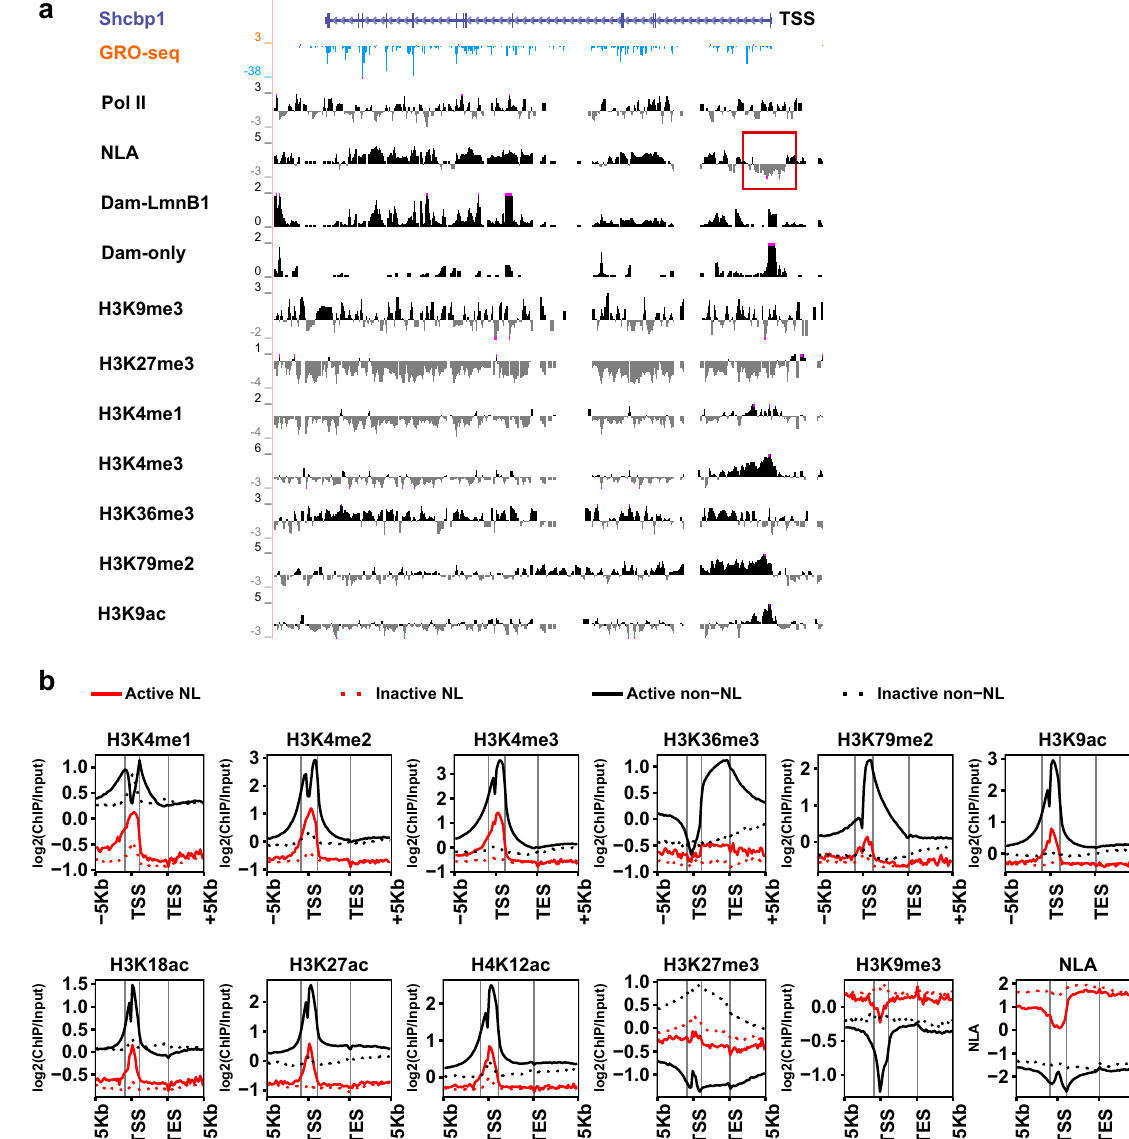
Figure 3. Combined analyses of gene activity, NLA and histone marks across genic regions. ( a ) The UCSC browser view of Shcbp1 – an active NL gene in C2C12 myoblasts. Data are binned in 200 bp. Tracks “Dam- LmnB1” and “Dam-only” display read densities (RPKM) of Dam-LmnB1 and Dam-only, respectively. Tracks of Pol II and histone marks are log2 of ChIP-Input enrichment computed from ChIP-seq data 21, 22 . The negative NLA values (shown as grey signals in the red square) around TSS in track “NLA” indicate NLA reduction at its promoter. ( b ) Comparing average levels of histone marks and NLA across genic regions (from TSS − 5 Kb to TES + 5 Kb) among active/inactive NL and non-NL genes. Data are computed based on 20 equally-divided bins along gene bodies or 200 bp bins otherwise. In each plot, grey vertical lines from left to right indicate TSS − 1 Kb, TSS + 1 Kb and TES,